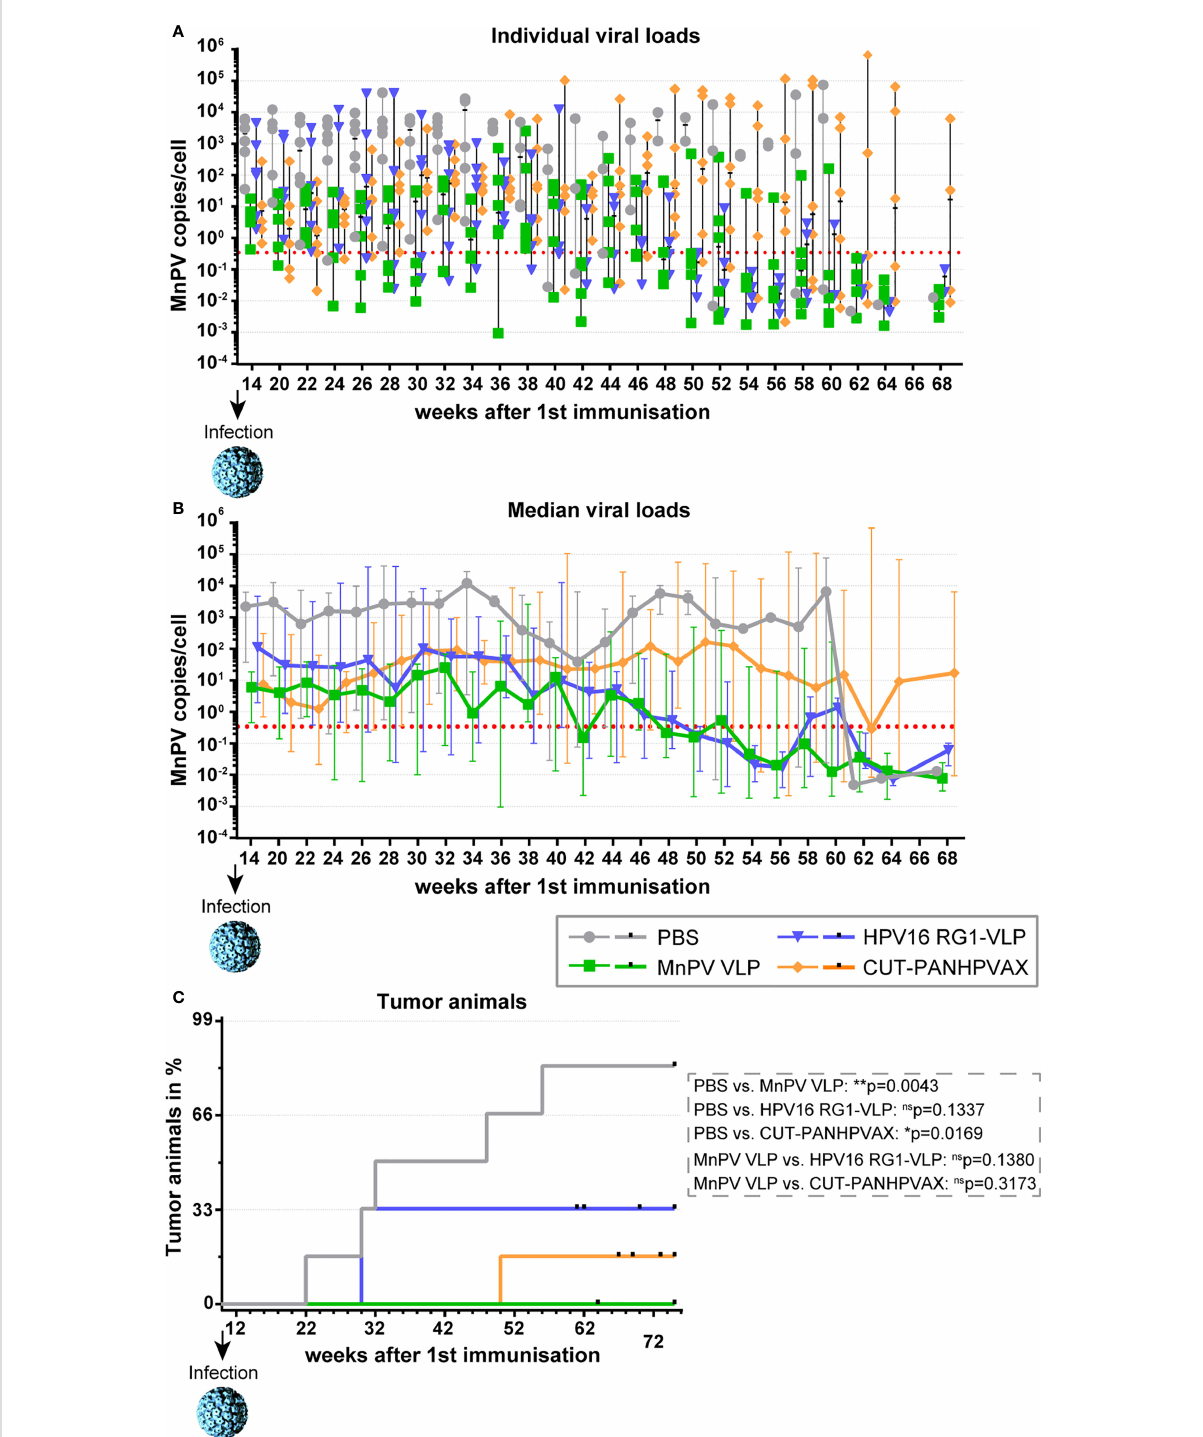
FIGURE 5 Monitoring viral load and tumor development after MnPV infection. (A) Viral load from plucked hair was followed over time via qPCR and is depicted (A) for individual animals or (B) for the vaccination groups (median ± range). Dashed lines represent the methods ’ cut-off based on hair extracted prior to experimental infection (0.346 copies/cell). (C) Appearance of tumor-bearing animals in the different vaccination groups. Small vertical bars indicate censored animals which died for unknown reasons before tumor development. Differences between groups were calculated via log-Rank